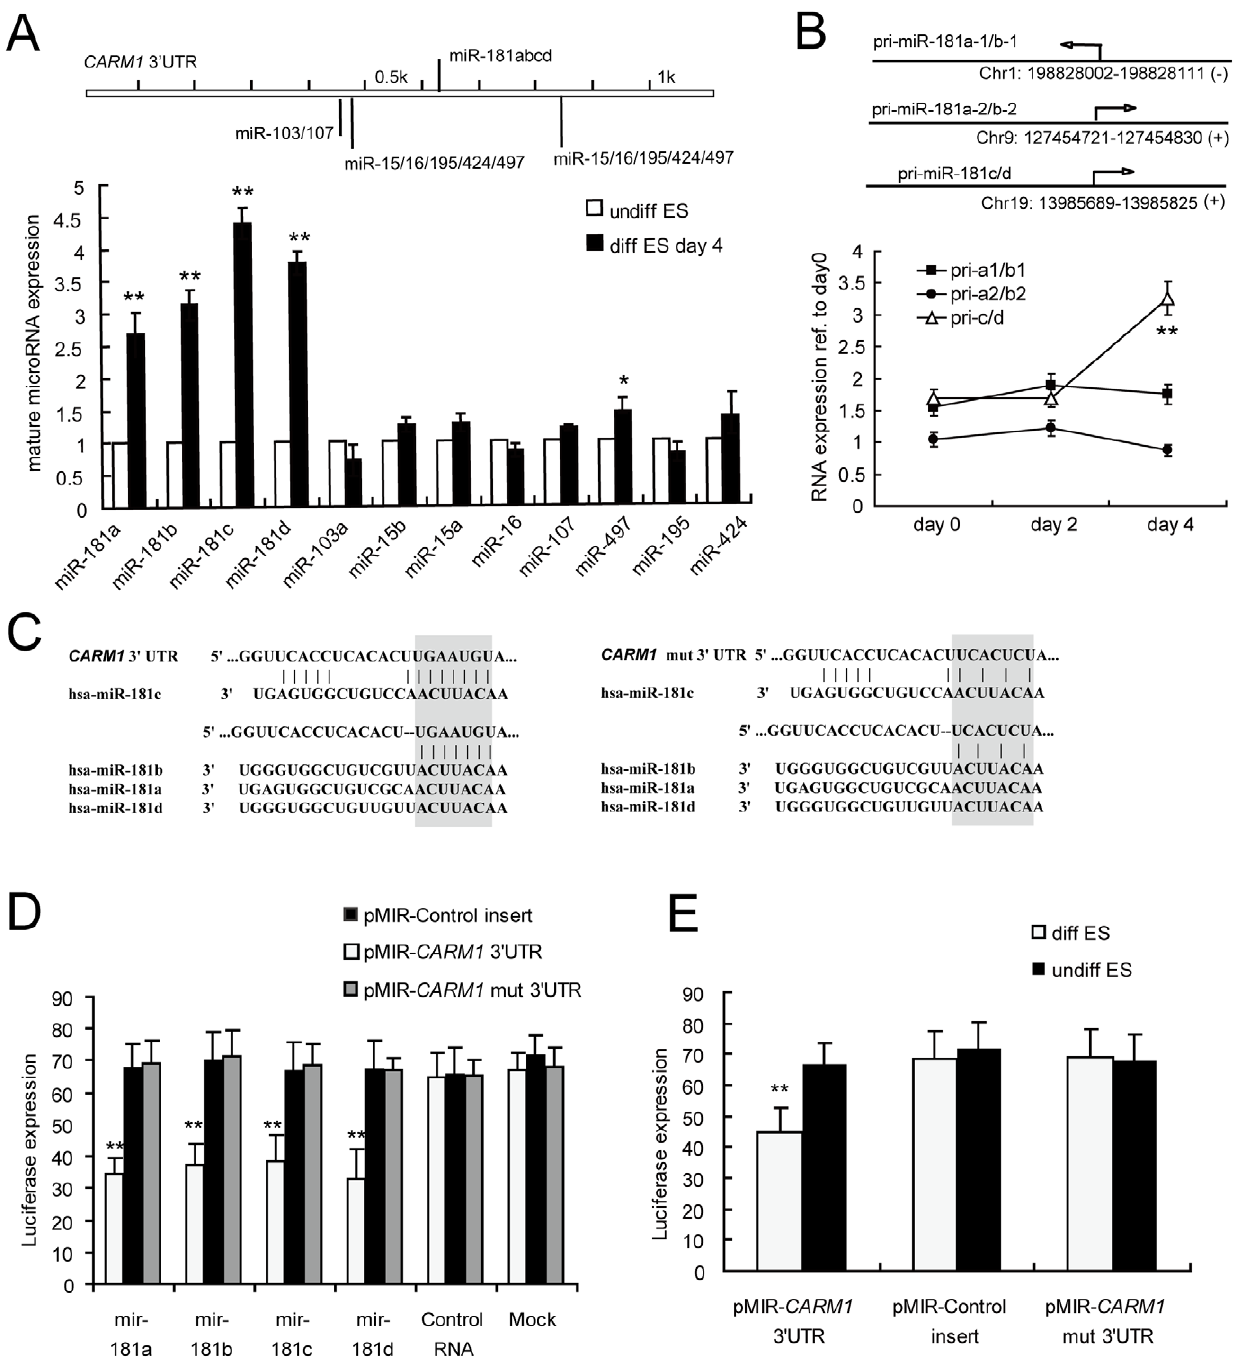
Figure 2. The miR-181 family directly regulates CARM1 expression in hESC. (A) The expression levels of mature miRNAs predicted to target the CARM1 3 9 UTR were monitored in differentiated ESCs by qRT-PCR and normalized to endogenous U6 expression. *, p , 0.05; **, p , 0.01. (B) The chromosome positions of the primary transcripts of miR-181 family members are shown, their expression levels in differentiated ESCs were determined by qRT-PCR and normalized to endogenous b -actin expression. **, p , 0.01. (C) The predicted consequential pairing of miRNAs and their target regions in the wild-type CARM1 3 9 UTR or the mutant (mut) CARM1 3 9 UTR are shown. (D) The HEK293 cells were co-transfected with the firefly- luciferase-expressing vector pMIR-REPORT containing the wild-type CARM1 3 9 UTR, the mut CARM1 3 9 UTR or the control insert as well as the internal control renilla-luciferase-expressing vector pRL-TK and the indicated RNAs. After 48 h, the luciferase activities were measured. The data were normalized by dividing firefly luciferase activity with that of Renilla luciferase, **, p , 0.01. (D) Luciferase activities were measured in human ESCs co- transfected with the pMIR-REPORT plasmid containing wild-type CARM1 3 9 UTR, mut CARM1 3 9 UTR or control insert and the internal control, pRL-TK. All the samples were assayed in duplicate (n=3). **, p , 0.01.